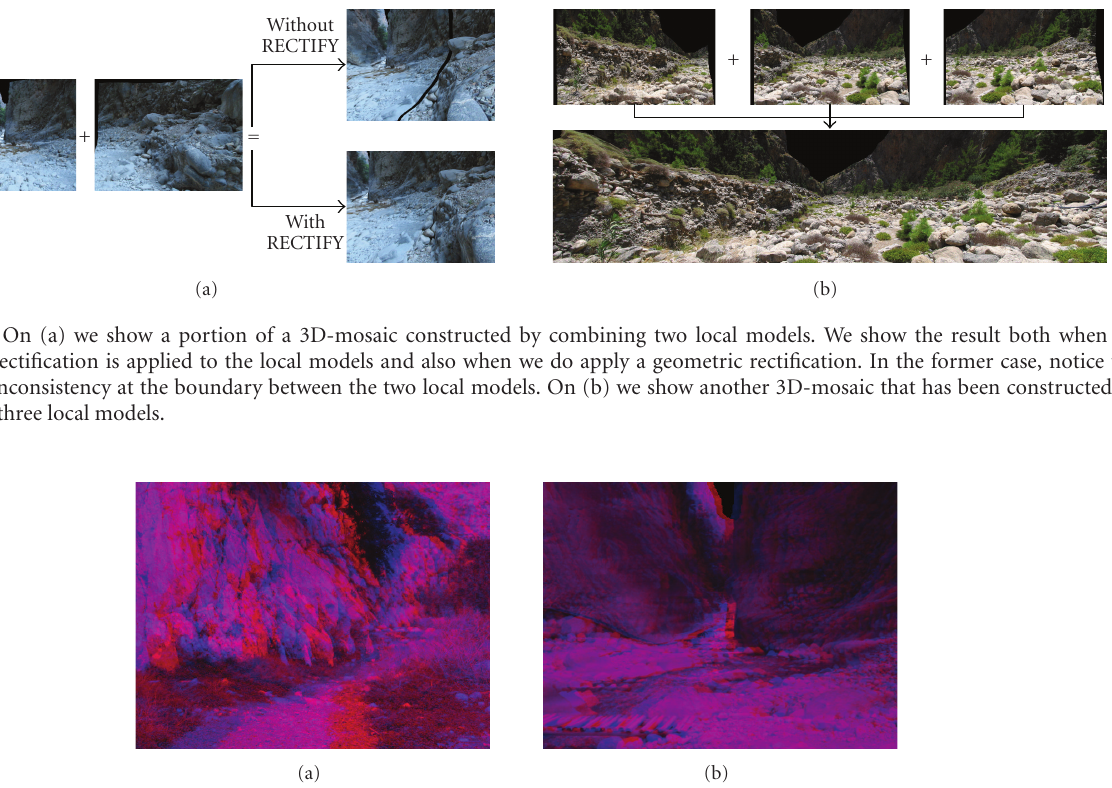
Figure 11: Two stereoscopic views as would be rendered by the VR system (for illustration purposes these are shown in the form of red-blue